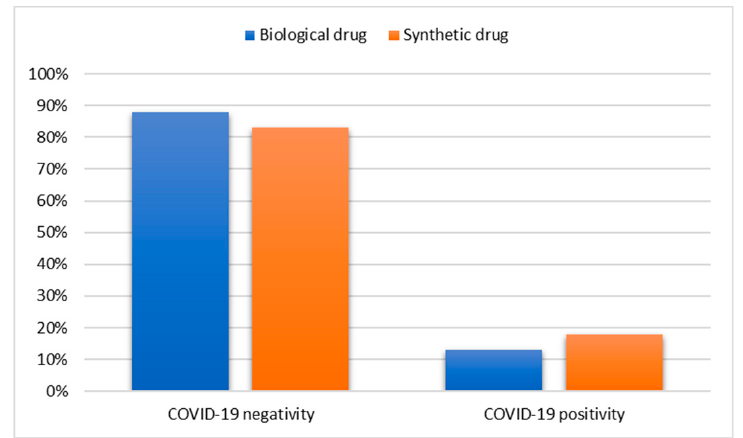
Figure 1. Association between COVID-19 positivity and type of drug used. Focusing on patients who were hospitalized for ARDS, the analysis revealed a signifi- cant association with the presence of comorbidity ( χ 2 = 16.07; df = 1; p = 0.001). Specifically, all patients who were hospitalized had a comorbidity at the same time (Figure 2). Since two cells had a count of less than 5, as a further check, Fisher’s exact test was applied, from which a significant dependency between the two variables in question emerged (F = 16.06; df = 1; p = 0.001). No significant connections emerged with the variables gender, pathology and type of